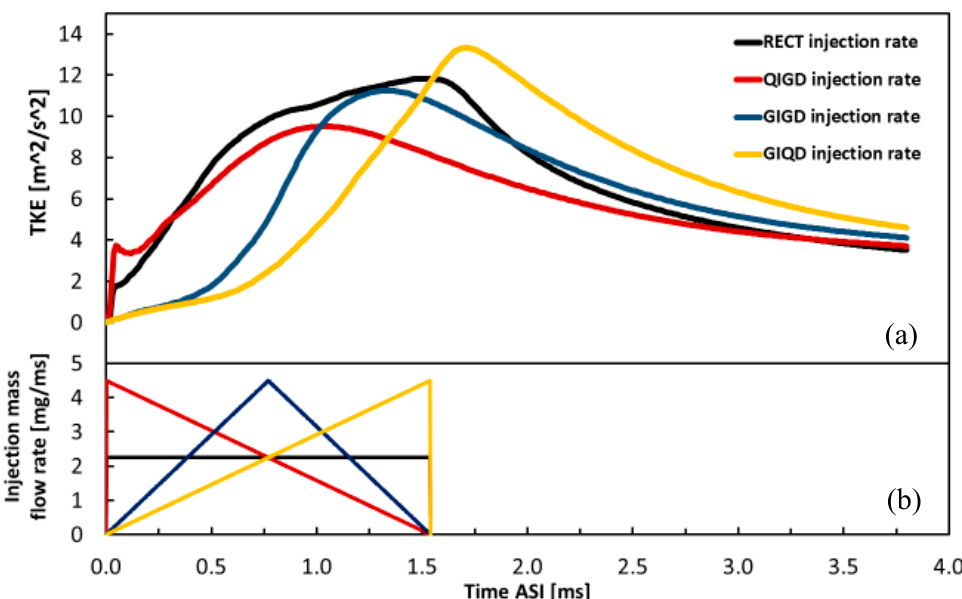
Figure 22. Comparison of the turbulence kinetic energy (TKE) for different injection rate shapes. ( a ) TKE and ( b ) injection mass flow rate.